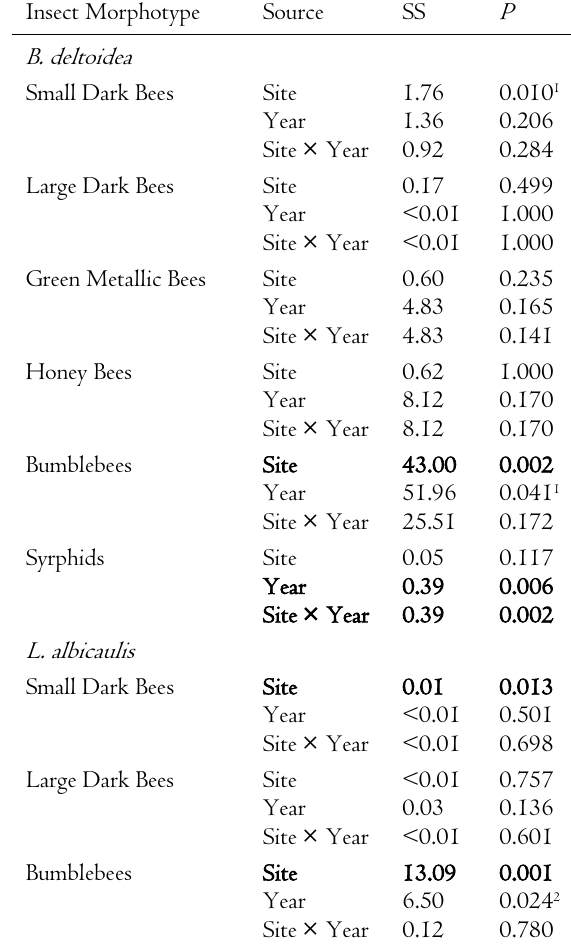
Results of permutative two-way ANOVAs (SS and P-values) comparing insect visitation rates at Webster nursery and Johnson prairie for both B. deltoidea and L. albicaulis in 2011 and 2012. Significant results are in bold. All significant site effect results indicate higher visitation rates at Webster Nursery than at Johnson Prairie. Bonferroni corrections for six tests (B. deltoidea) would necessitate an alpha = 0.008, and for three tests